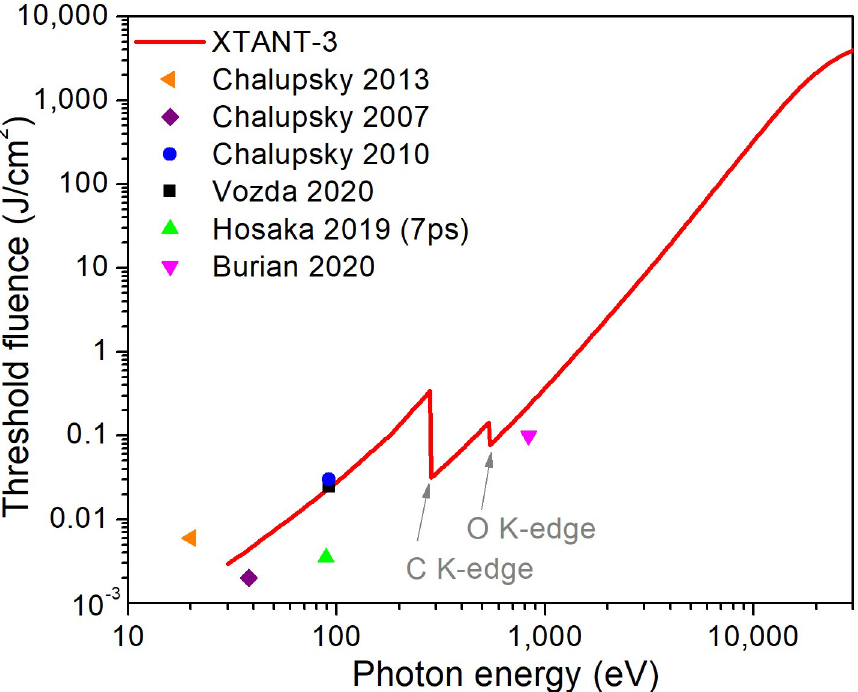
Figure 9. The damage threshold fluence in PMMA as a function of incoming photon energy esti- mated with XTANT-3 and available experimental data [1,2,5,32–34]. with XTANT-3 and available experimental data